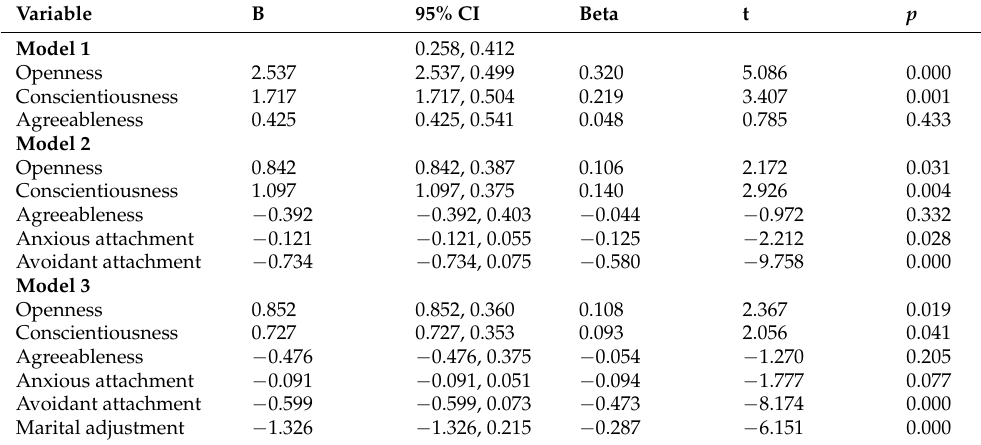
Table 4. The beta coefficients for the multiple linear regression analysis of the investigated vari- ables: marital (couple) satisfaction, openness, conscientiousness, agreeableness, anxious attachment, avoidant attachment, marital